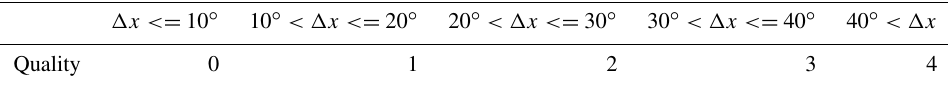
Table A2. Classification of the qualities used for focal mechanisms. (cid:49) x represents (cid:49) strike, (cid:49) dip and (cid:49) rake. The lowest quality of all three parameters is given to the fault plane